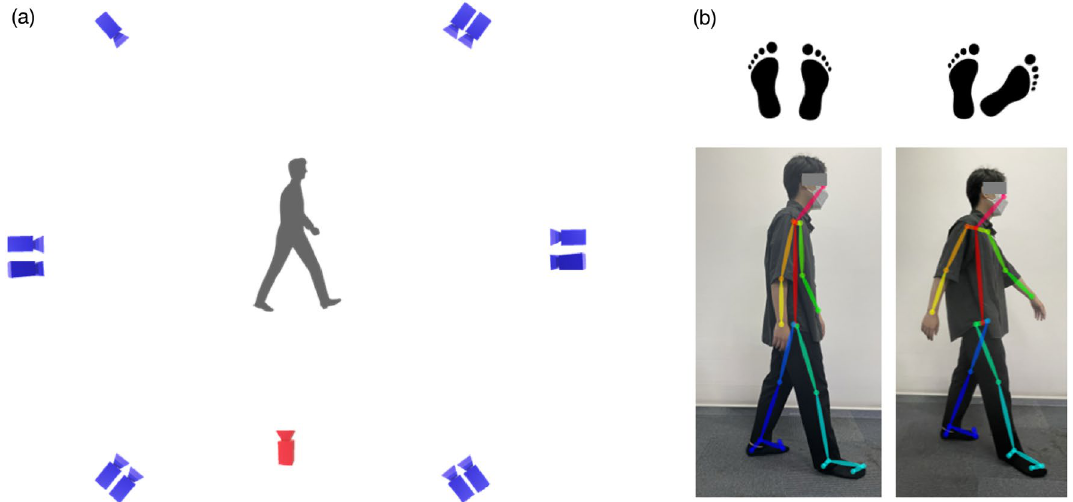
Figure 1. Overview of the experimental set up and body model of OP. ( a ) Approximate position of infrared cameras for 3DMC (blue) and an RGB camera for OP (red). ( b ) Body keypoints estimation by OP. BODY_25 model used in this study. Left side gait condition is normal foot progression angle (FPA), whereas right side is large spines, lateral thighs, medial and lateral epicondyles of the femurs, lateral shanks, medial and lateral malleoli, calcanei, head of second and fifth metatarsals, and tip of the second toes. An RGB camera with a pixel resolution of 720 × 520 (Basler AG, Ahrensburg, Germany) was used for the 2D analysis using human pose estimation. This camera was positioned 3 m away from the participants, and it captured their dominant leg. The height of the camera was set at the greater trochanter of each participant. The RGB camera data were used for 2D pose estimation by OP. In the first stage, the part affinity fields, which form a set of 2D vector fields that encode the location and orientation of the extremities over the RGB images, were predicted 15 . In the second stage, the confidence maps of each human body segment location are predicted. Both stages were parsed to output 2D keypoints of the human body in the images. For the OP output, we used the Body_25 model, which provides the 2D coordinates of the 25 body keypoints in each RGB image (Fig. 1). More details on OP have been described by Cao et al. 15 . The data from 3DMC and OP were recorded at a sampling rate of 100 Hz, and 4th order low-pass Butterworth filter with a 6 Hz cutoff frequency was used. Data processing and proposed method for ankle joint angle. Temporo-spatial parameters, such as gait speed, stride length, stance time, and swing time were measured for each gait condition. In the 3DMC method, the midpoint of both posterior superior iliac spine (PSIS) markers was used to calculate the gait speed, whereas the gait speed measurement using the OP and the proposed method was calculated from the mean midhip keypoint velocity of the walkway direction in the 2D video. In both methods, initial contact/toe-off were defined based on the maximum or minimum point of antero-posterior distance between heel/second metatarsal head and midpoint of PSIS in 3DMC or heel/ big toe and midhip in OP by referring to a previous study 30 . Stride length was calculated from the distance between the initial and the next initial contact point of the dominant heel marker or keypoint coordination. In the OP method, the distance was calculated based on the length of tape on the walkway and number of pixels of the tape in the RGB camera image. In addition, representative kinematic parameters of peak joint angles for gait assessment were selected by referring to previous studies 31,32 . In the 3DMC method, flexion-extension angles of the lower limb joints were calculated using Skycom software (Accuity Inc., Tokyo, Japan). Hip, knee, and ankle joint flexion-extension angles in the OP method were cal- culated by body segment vectors. Keypoints for body segment vector were as follows: trunk, neck and midhip; thigh, hip and knee; shank, knee and ankle; foot, ankle and big toe. The hip angle was calculated from trunk and thigh segment vector. The knee angle was calculated from thigh and shank segment vectors. The ankle angle was calculated from shank and foot segment vectors. Joint angles in the OP method were calculated as follows: